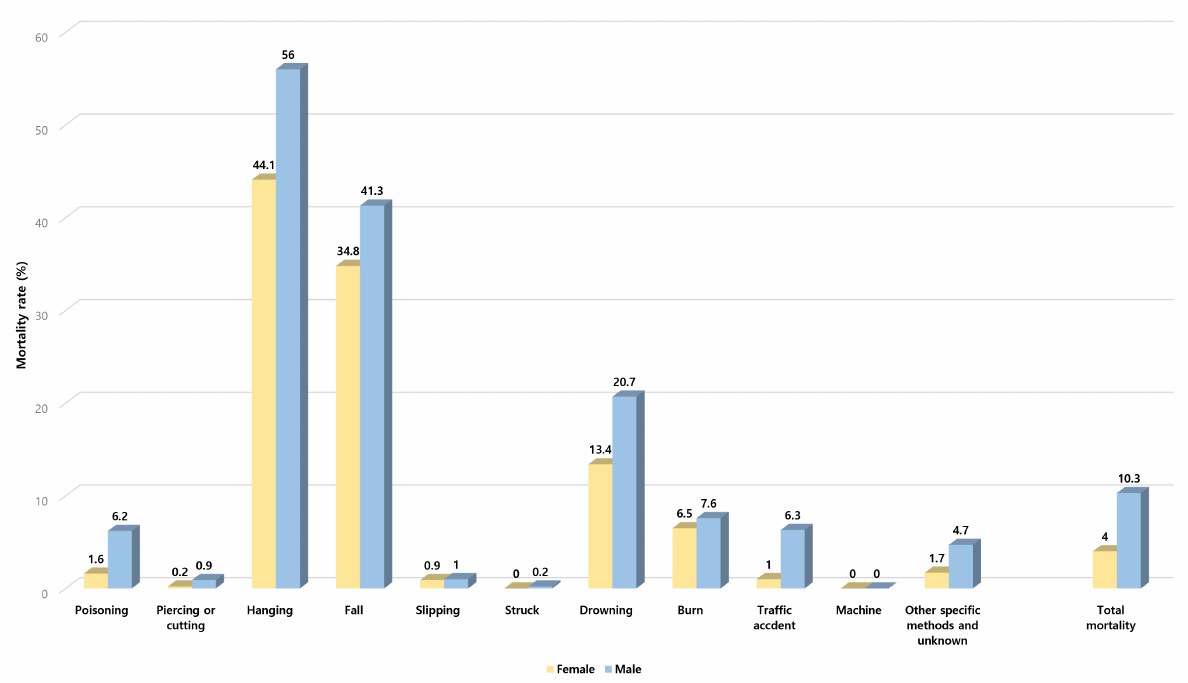
Fig. 4. Method-specific mortality rates by